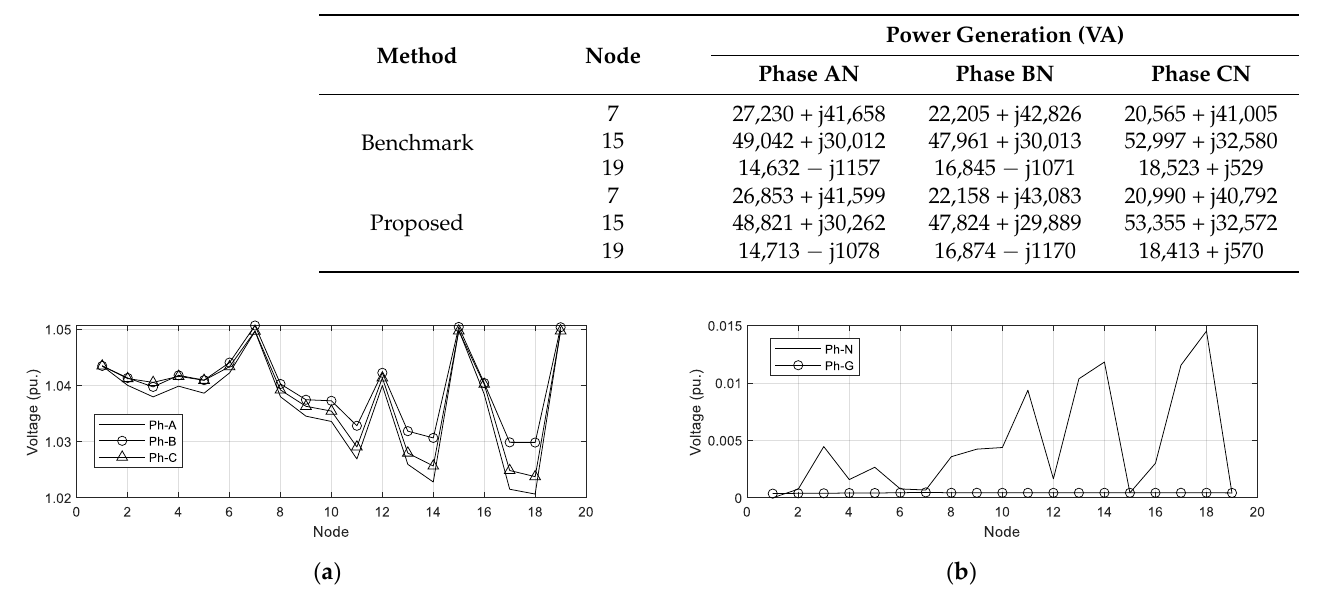
Figure 14. Phase voltage results of ( a ) Phase − A, − B, and − C and ( b ) Phase − N and − G.